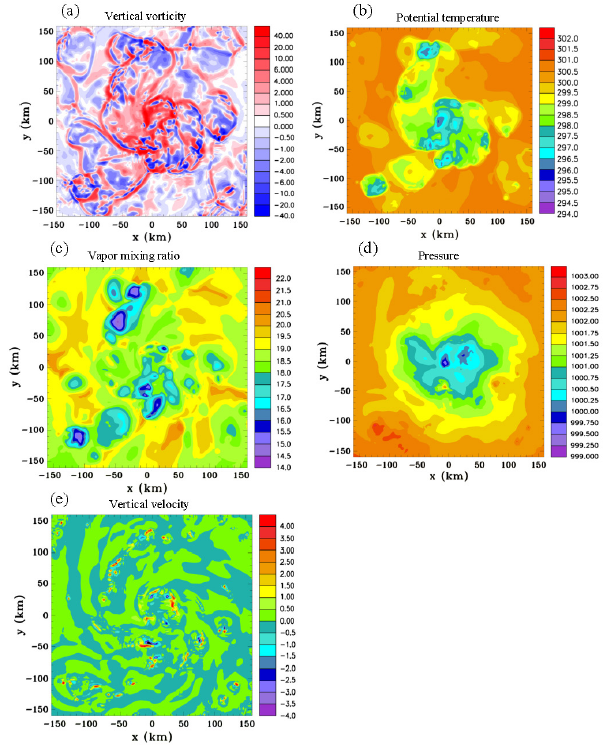
Fig. 17. Zoomed horizontal and vertical sections for Experiment 2, at t = 79 h. (a) CAPE (J kg − 1 ), (b) pressure (mb) and wind vec- tors (max 11ms − 1 ), (c) temperature perturbation (K), (d) vertical vorticity ( × 10-4 rad s − 1 ) and wind vectors, at z = 98 m, and (e) potential temperature perturbation (K) and y velocity ( v ) contoured at 2ms − 1 intervals. (f) Vertical vorticity ( × 10 − 4 rad s − 1 ) and x - z wind vectors (max 8ms − 1 ), in the y plane at y = 2